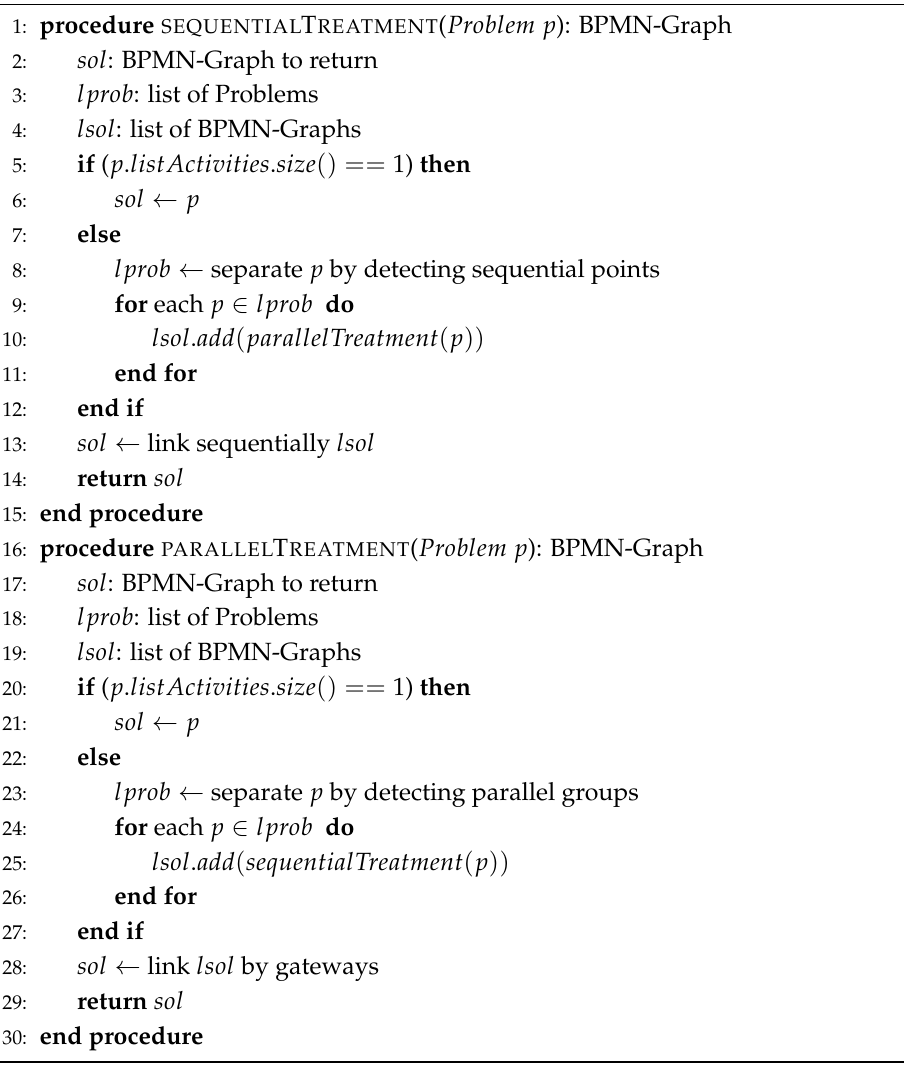
Algorithm 2 Create a BP model from COP result.